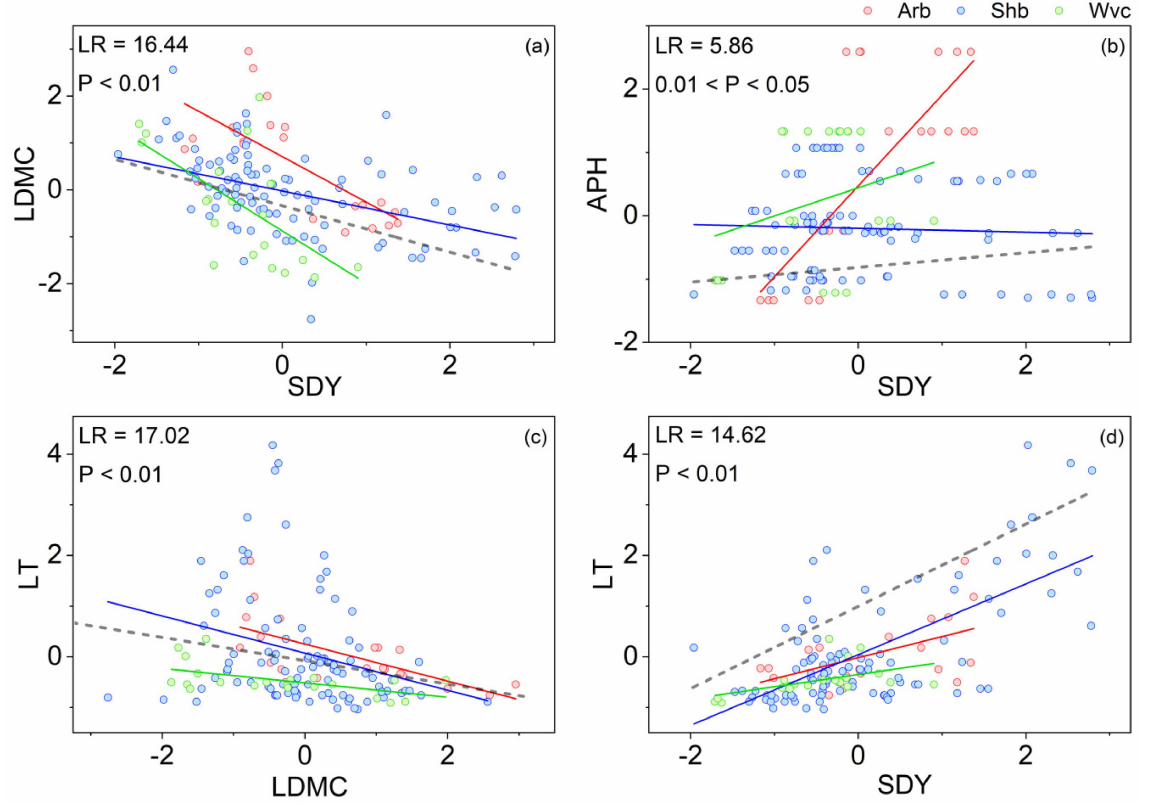
Figure 6. SMA of correlation among woody plant functional traits across WFTs. Subfigures ( a – d ) show the binary relationships between different functional traits. Colors indicate individ- ual WFTs; dashed black lines indicate significant relationships in the full dataset; the LR tests indicate significant differences between the slope of the WFT-specific SMA lines; only significantly different combinations in SMA analysis are listed here. Abbreviations are as follows: LDMC, leaf dry matter content; SDY, stem density; LT, leaf thickness; APH, average plant